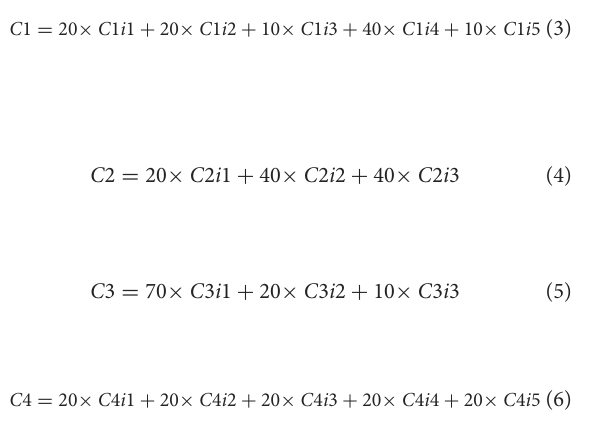
The values of the four criteria are calculated by formulas (3), (4), (5) and